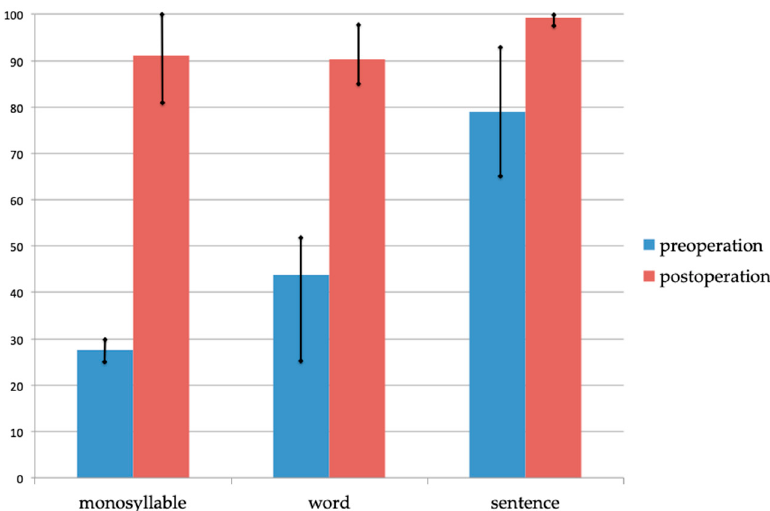
Figure 4. Mean scores of the Japanese monosyllable, word and sentence tests pre-cochlear implantation (CI) and six months post-CI. The scores pre-CI are with hearing aids. n = 2 pre-CI ( n = 3 in word perception tests pre-CI) and n = 4 post-CI.